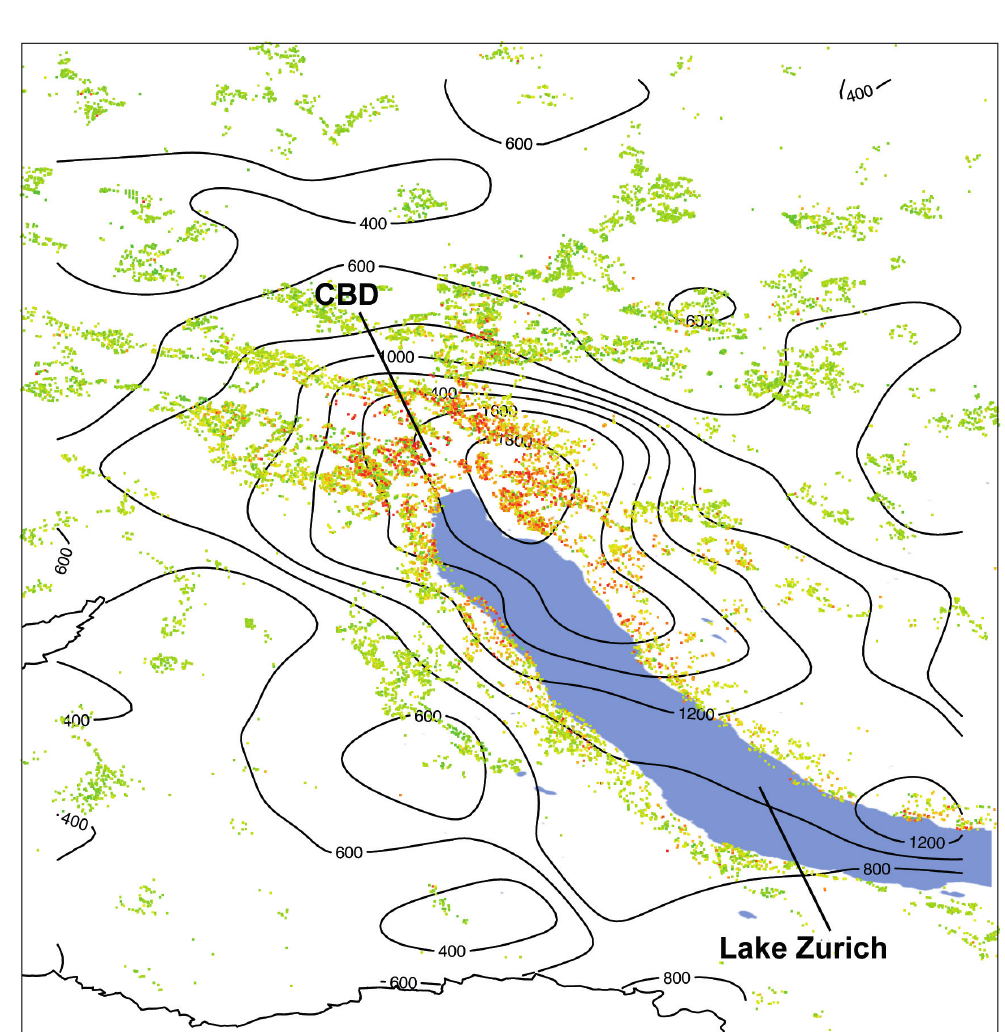
Figure 6. Nonparametric estimates of predicted land values. (This figure shows the predicted land values as the product of location quality and land quality. The oval gradients of land prices reflect the monocentric structure of land quality in the metropolitan region of Zurich. High location values can be observed along the lakeside as well as more in the north next to the lake, i.e., high floor area ratios reflect high local